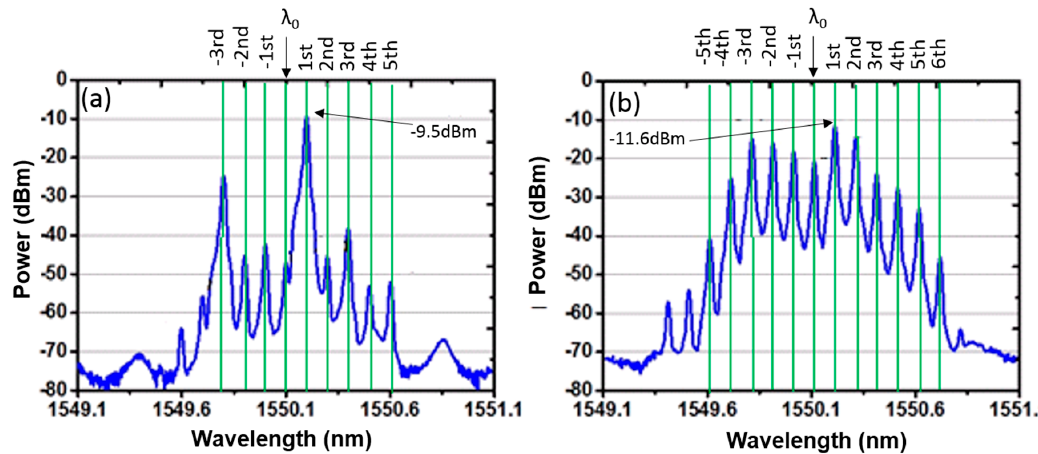
Figure 12. Representative optical spectrum ( a ) emerging from the DP-MZM subject to the optimum operating conditions for the 1-st converted optical component; ( b ) emerging from the DP-MZM subject to non-optimized operating conditions.